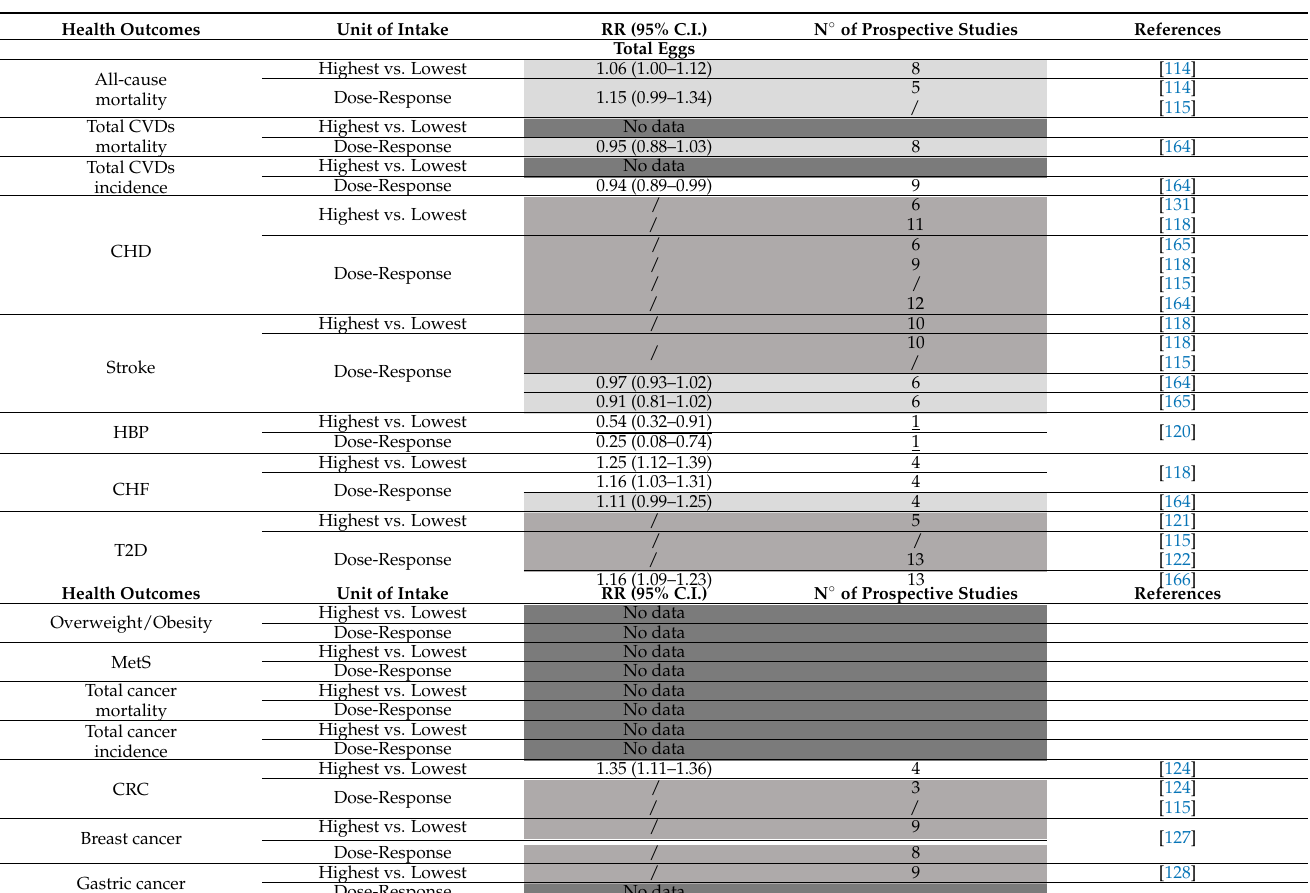
Table 5. Association between egg intake and incidences of some major chronic diseases/mortality of major disease groups (RR, 95% C.I.). The dose-response meta-analysis always refers to an additional serving of a food per day relative to the average intake of that food observed in a cohort study (50 g for